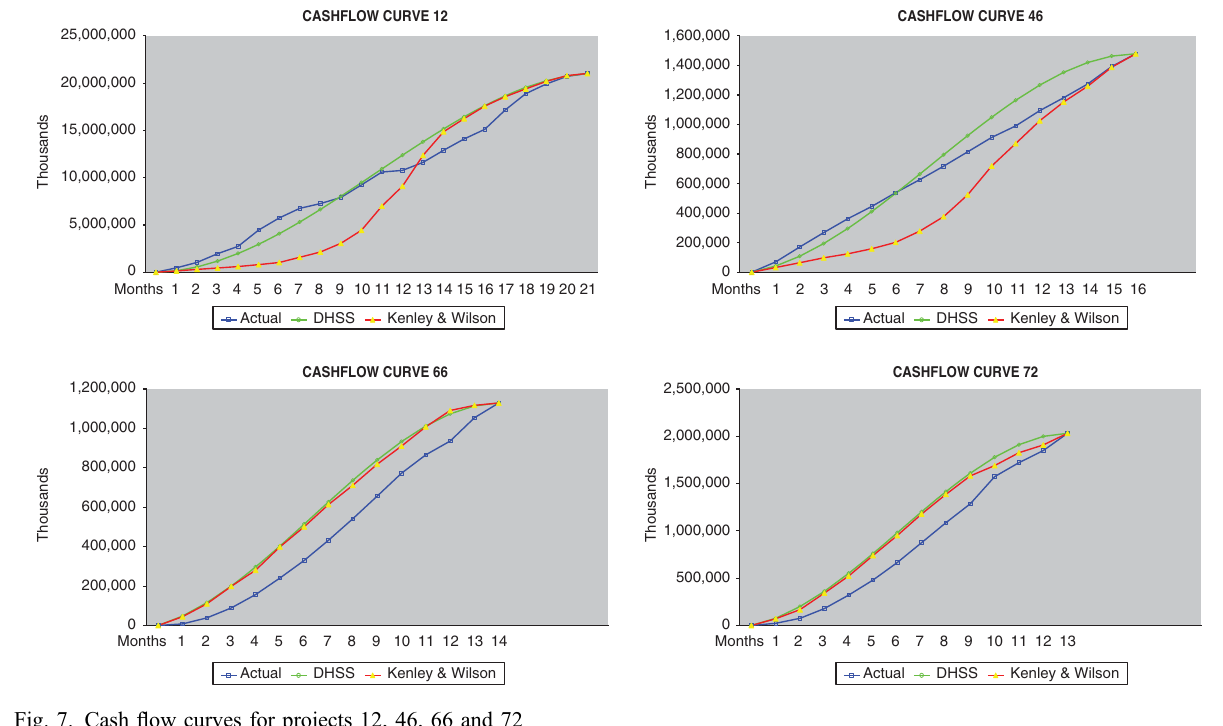
Table 4. The parameter values recommended for the specific variables (revised parameter values for the DHSS model to take account of variables studied in this research)